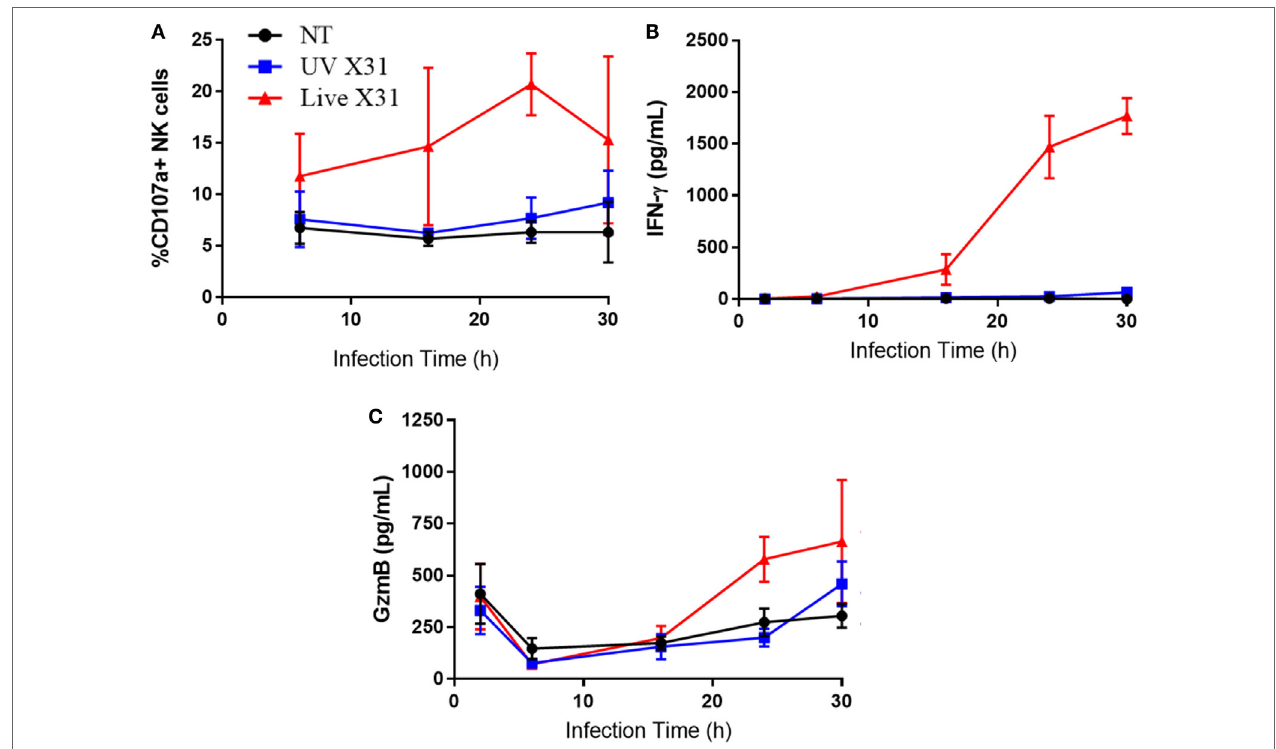
FigUre 8 | Explant response to X31 infection over time. (a) Natural killer (NK) cell surface expression of CD107a. (B,c) Extracellular secretion of IFN- γ (B) and granzyme-B (c) from infected lung tissue ( N = 3, except 6 h N = 2). Lines describe mean and